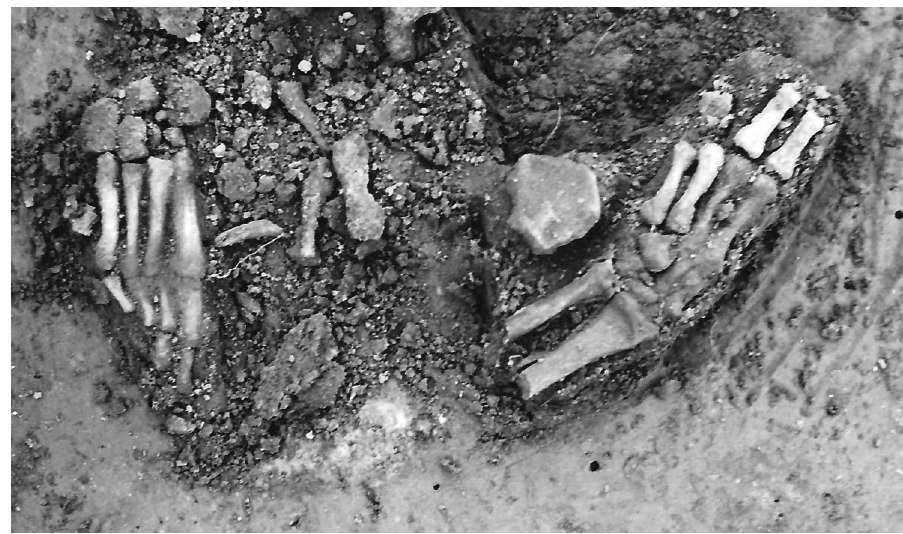
Figure 4: Fragmented distal right radius and ulna, and shovel